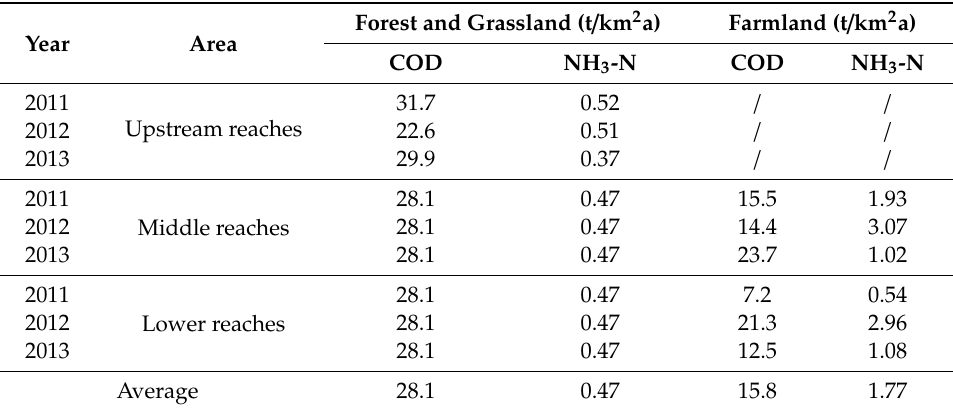
Table 3. Pollutant yield coefficient according to land use.